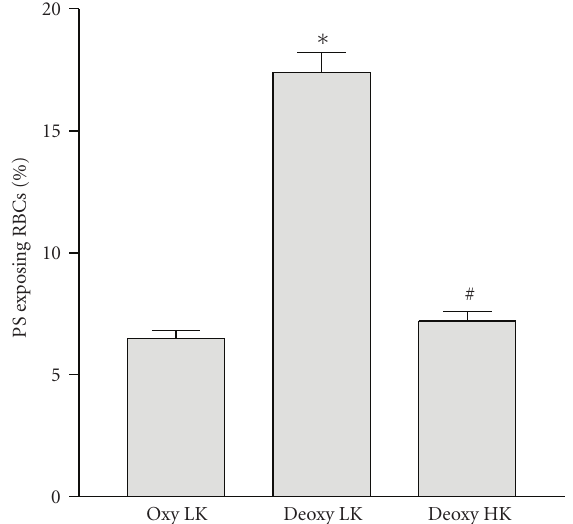
Figure 3: E ff ect of extracellular K + on phosphatidylserine (PS) exposure in red blood cells (RBCs) from sickle cell patients. RBCs were incubated for 18 hours with extracellular [Ca 2+ ] of 5mM under oxygenated (20% O 2 ) or deoxygenated (1% O 2 ) conditions in either low K + -containing (extracellular [K + ] of 5mM) saline or high K + -containing (90mM [K + ]) saline. Histograms represent means ± S . E . M . ( n = 3). ∗ P < . 001 compare to LK oxy; # N.S. cf. LK oxy.